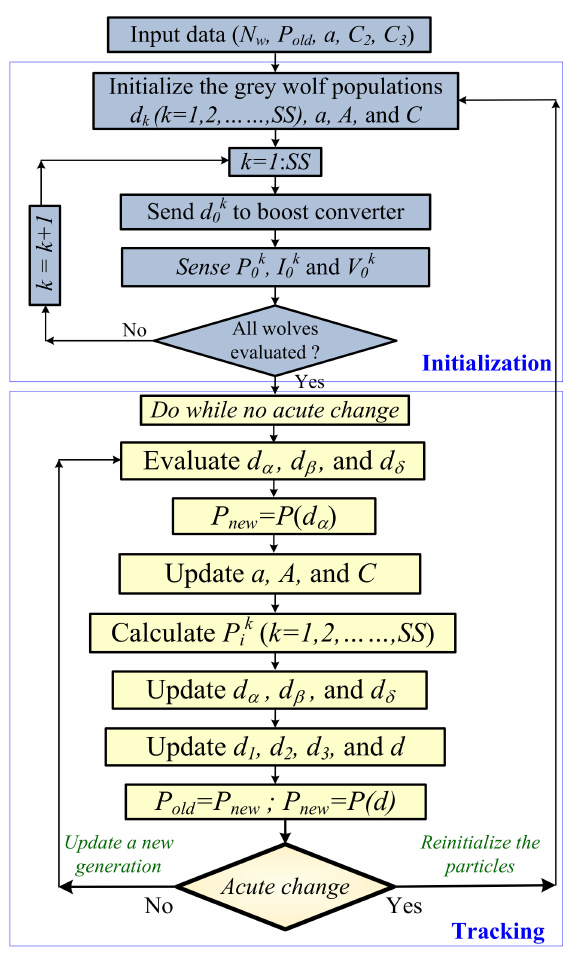
Figure 8. Flowchart of GWO based on MPPT of PV